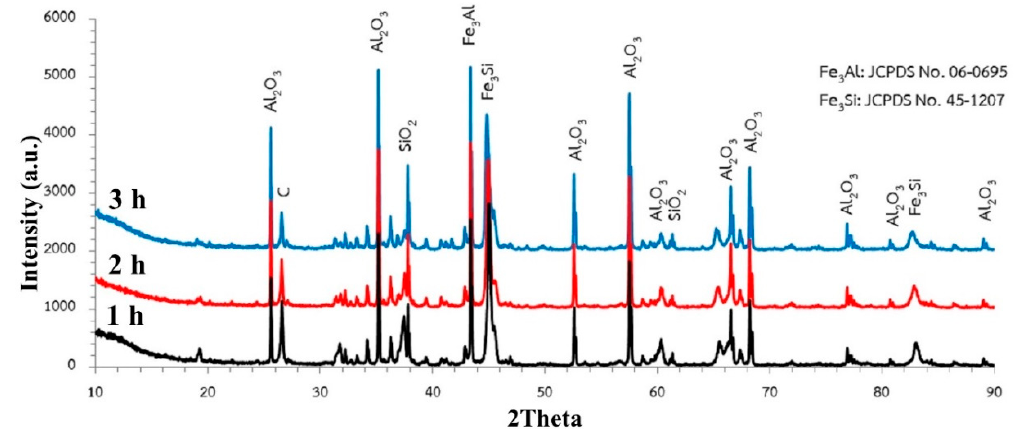
Figure 5. XRD patterns of the pellet (C/O = 1.5) after heating at 1550 °C for up to 3 h.